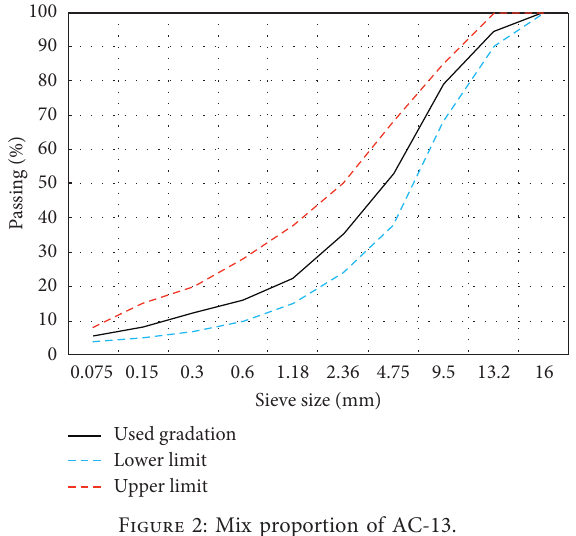
Figure 2: Mix proportion of